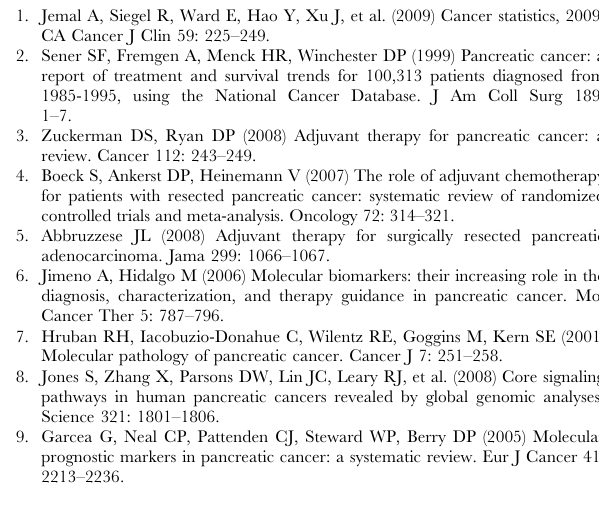
Table S9 Korean cohort: association miR-21 and immunohis- tochemistry covariates. Table S10 Italian cohort: univariate analysis in adjuvant treated